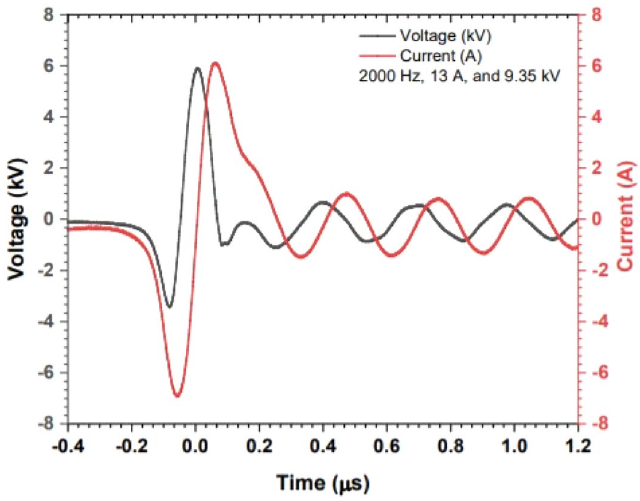
Figure 2. The typical current–voltage waveforms for the large volume atmospheric pressure air plasma at operating conditions of 2000 Hz and 1.5 cm discharge gap 2000 Hz, 13 A, 9.35 kV and 10.94